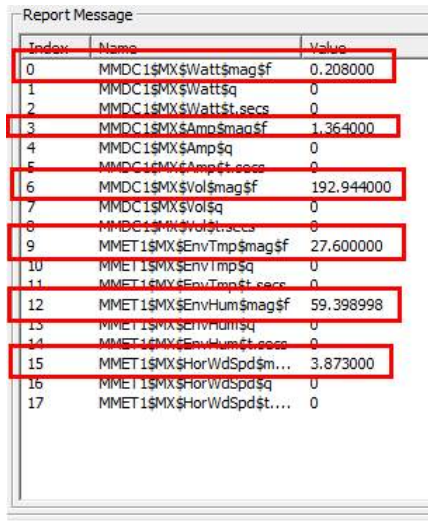
Figure 10. Solar panel measurement results at 11